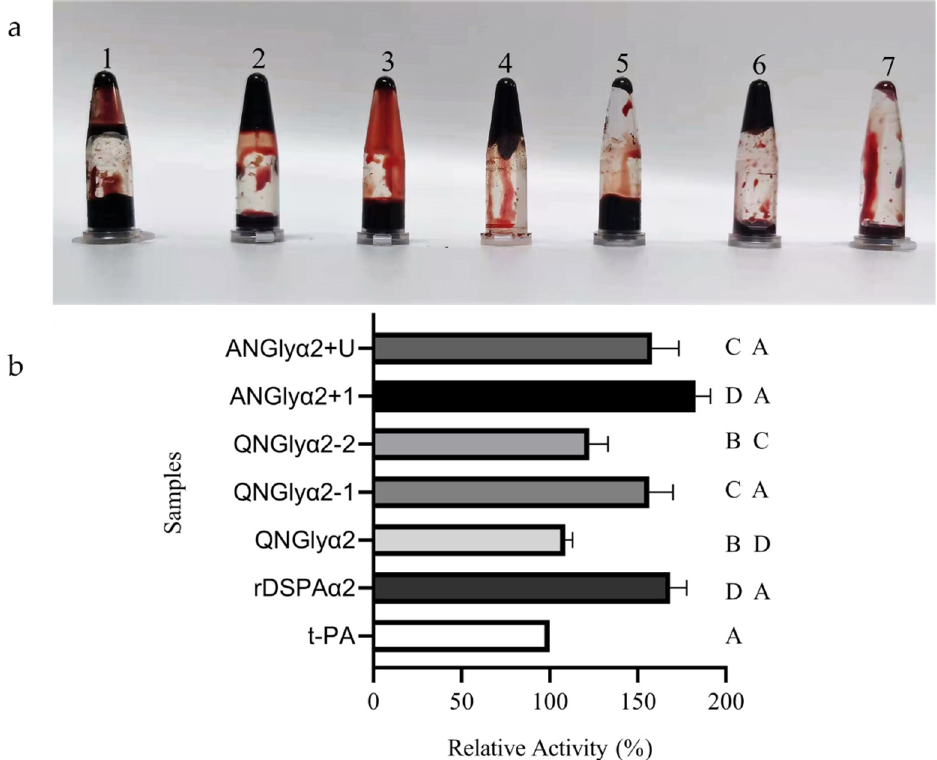
Figure 6. Comparison of clot lyses. ( a ) The results of the clot lysis assay. Tubes 1–7: rDSPA α 2, QNGly α 2, QNGly α 2-1, QNGly α 2-2, ANGly α 2+1, ANGly α 2+U, and t-PA, respectively. ( b ) The relative activity of the rDSPA α 2 and its mutants. The activity of all samples was compared to that of t-PA (10 U) to determine the relative activity, which is displayed in percentages. Values are mean ± SD of the three replicates. AB means 0.01 ≤ p ≤ 0.05, AC means 0.001 ≤ p ≤ 0.01, AD means p ≤ 0.001.